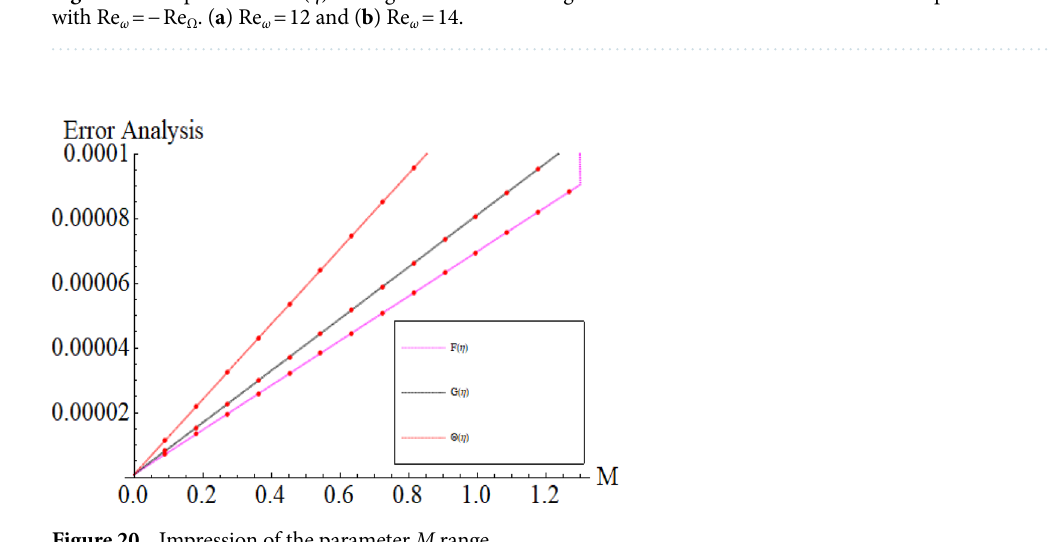
Figure 20. Impression of the parameter M